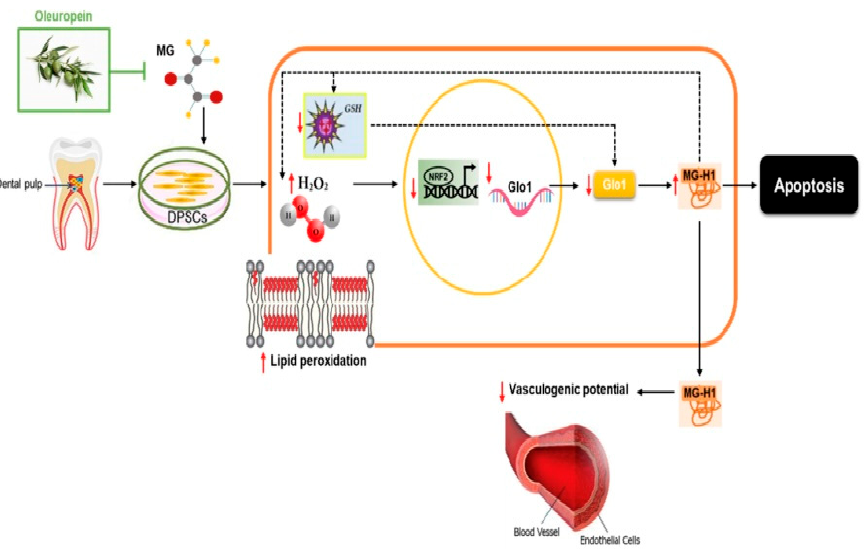
Figure 5. Mechanism of action of MG and OP on DPSCs. MG would provoke oxidative stress as a result of the Nrf2 pathway and down-stream Glo1, with the consequent release of MG-H1, eventually leading to DPSC apoptosis, while OP, by preventing this mechanism, plays a pivotal protective role against MG damage in DPSCs (Reprinted/adapted with permission from Ref. [138] . 2021, MDPI)